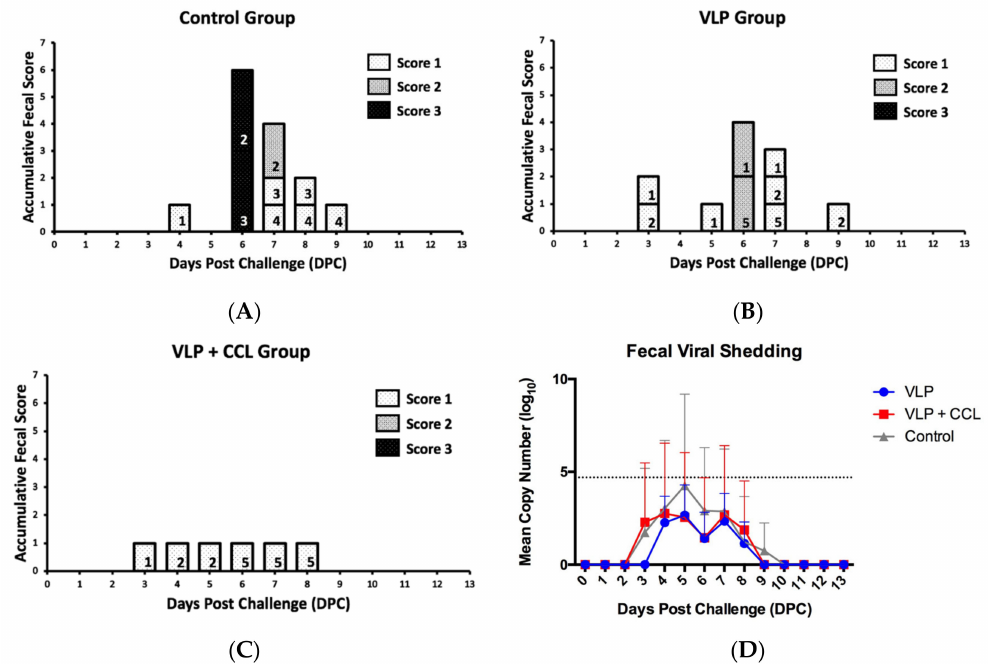
Figure 11. Evaluation of the protective e ffi cacy of di ff erent treatments. Pigs in all groups were challenged by the highly virulent porcine epidemic diarrhea virus Pintung 52 (PEDV-PT) strain passage 7. The post-challenge pigs were monitored for stool consistency and fecal viral loads for 13 days. ( A – C ) The result of stool consistency scoring in each group. According to the stool consistency, the stool was graded as 0 for normal; 1 for loose feces; 2 for semi-fluid feces; and 3 for watery feces. The total number of pigs in the control, VLP, and VLP + CCL groups was 4, 5, and 5 pigs, respectively. The Arabic numerals labeled in the bar indicate the individuals in each group. ( D ) The result of fecal viral shedding in each group detected by probe-based quantitative reverse transcription PCR (RT-qPCR) targeting the PEDV N gene. The results were presented as mean value of log 10 RNA copies / mL ± SEM. The detection limit of RT-qPCR was 4.7 log 10 (copies / mL) marked as a dotted